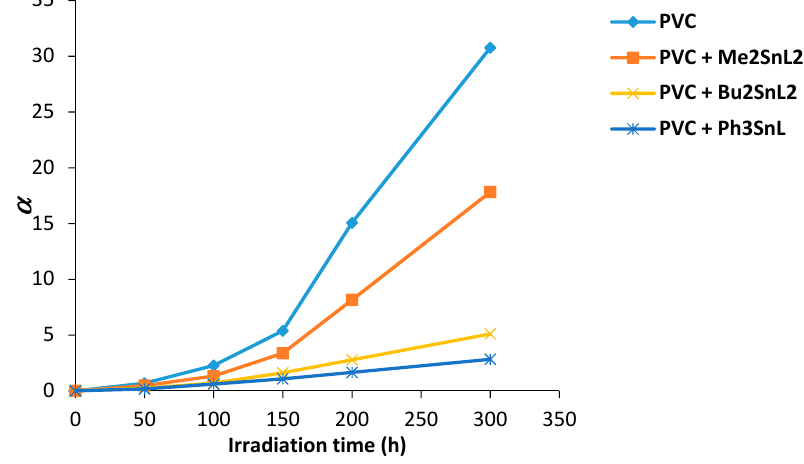
Figure 9. Changes in the degree of deterioration ( α ) for PVC films versus irradiation time.